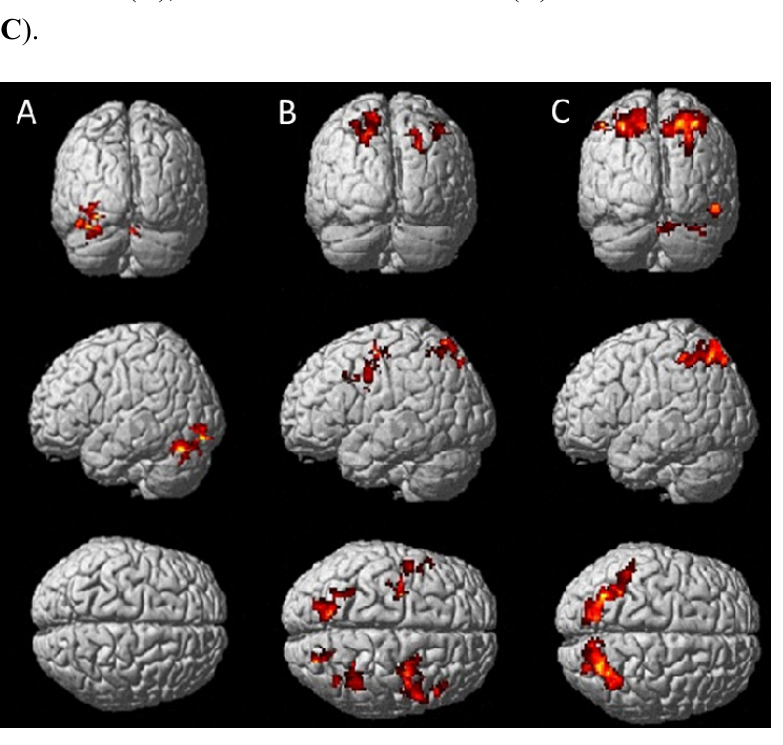
Figure 3. Posterior ( top panel ) and left lateral surface ( middle ) and dorsal ( bottom ) views of brain surfaces showing activation during the IT task for Berocca Performance > Placebo ( A ), Berocca Boost > Placebo ( B ) and Berocca Boost > Berocca Performance ( C